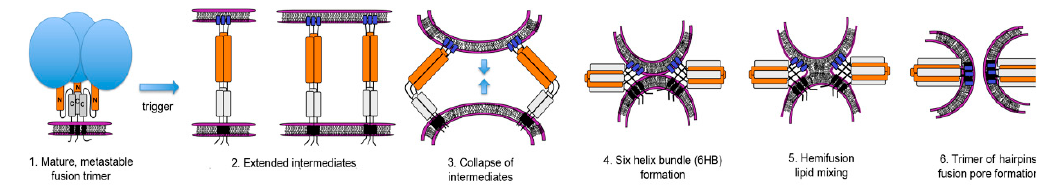
Figure 1. Current model of Class 1 viral fusion protein mediated membrane fusion pathway.